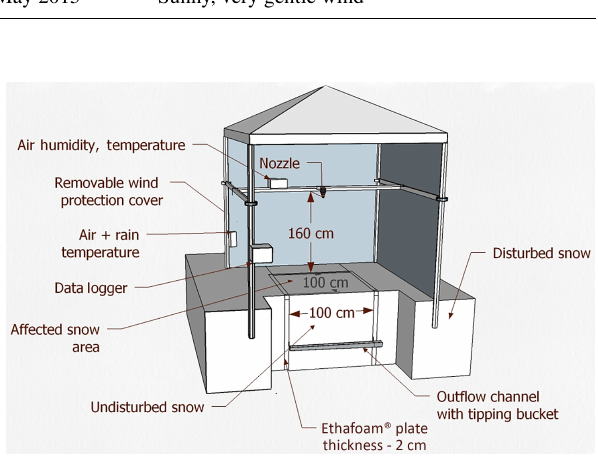
Figure 1. Experimental setup of rainfall